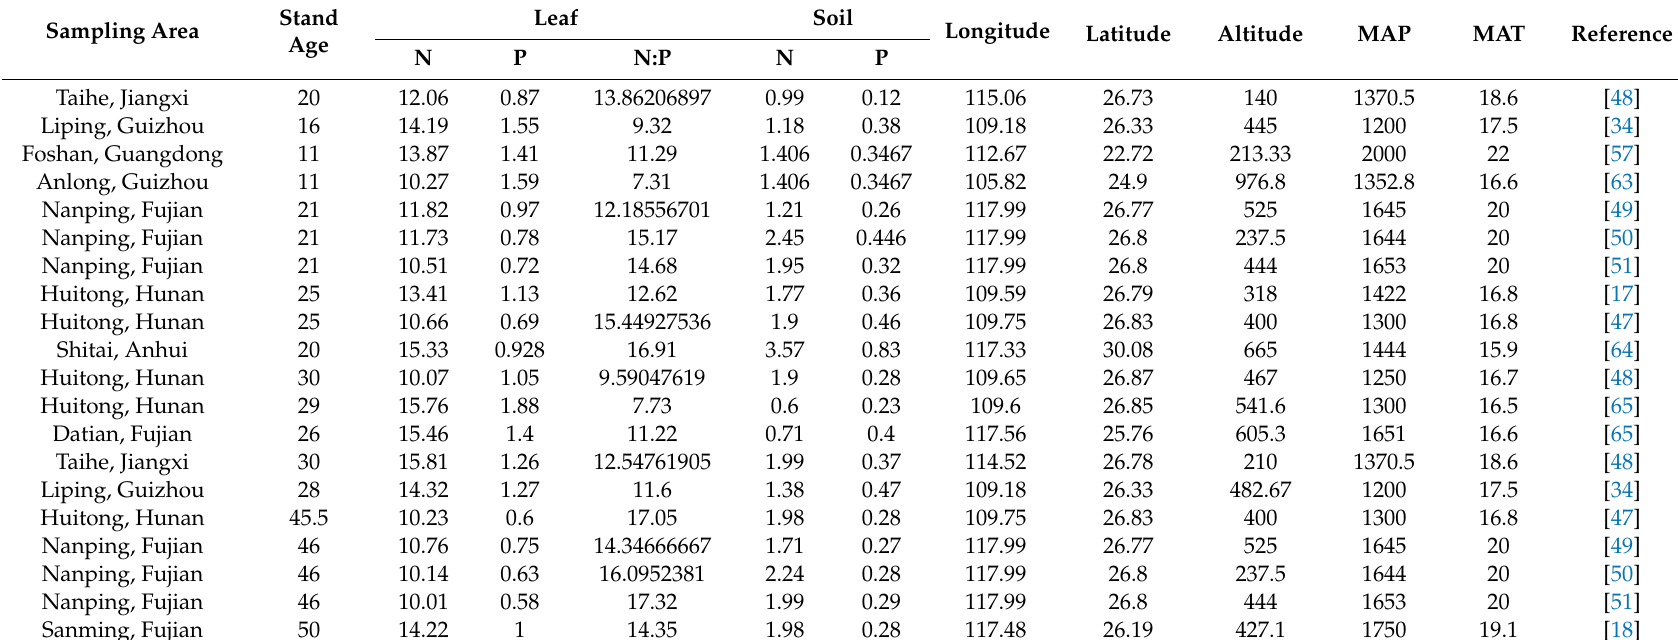
Note: the values of soil N and P concentrations with blue color represent the mean value of single age